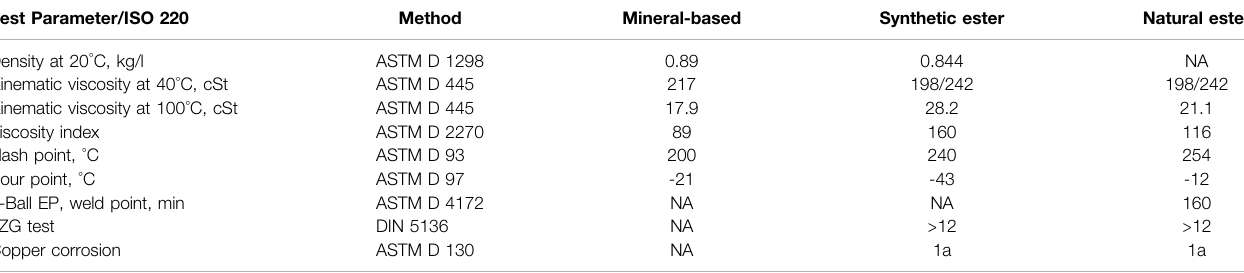
TABLE 2 | Basic physicochemical properties of mineral oil, natural ester, and synthetic-based for food-grade gear oils. Test Parameter/ISO 220